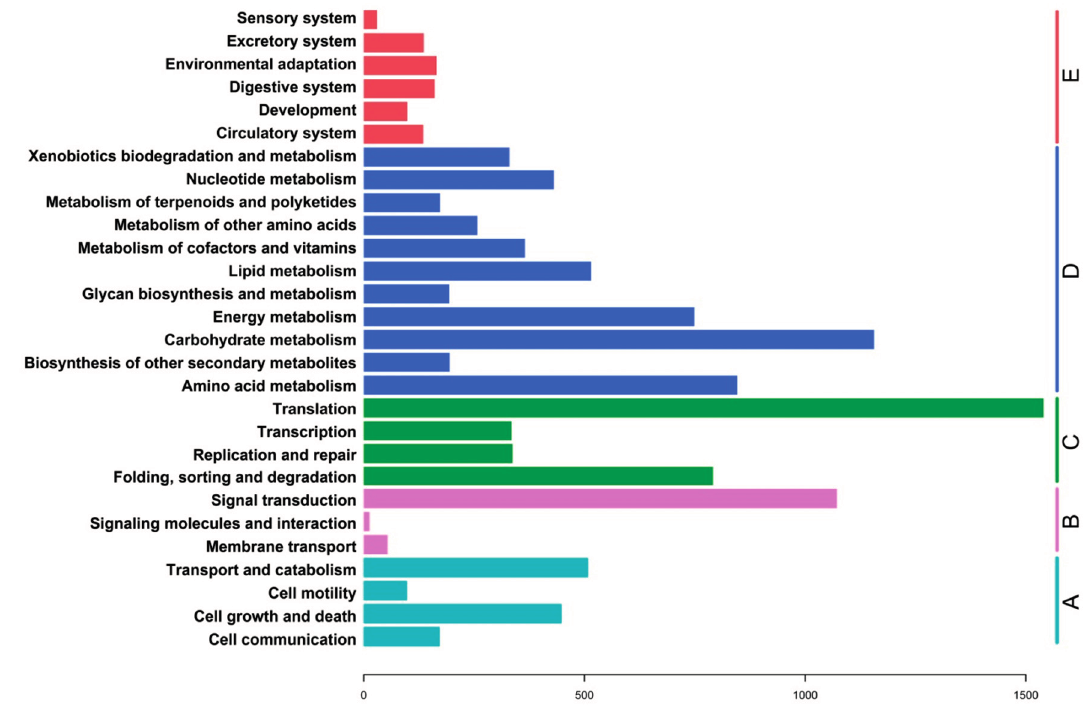
Figure 5. KEGG classification of assembled unigenes. A total of 6502 assembled sequences were associated with 2755 predicted KEGG metabolic pathways and were assigned to five KEGG biochemical pathways: ( A ) cellular processes; ( B ) environmental information processing; ( C ) genetic information processing; ( D ) metabolism; and ( E ) organismal